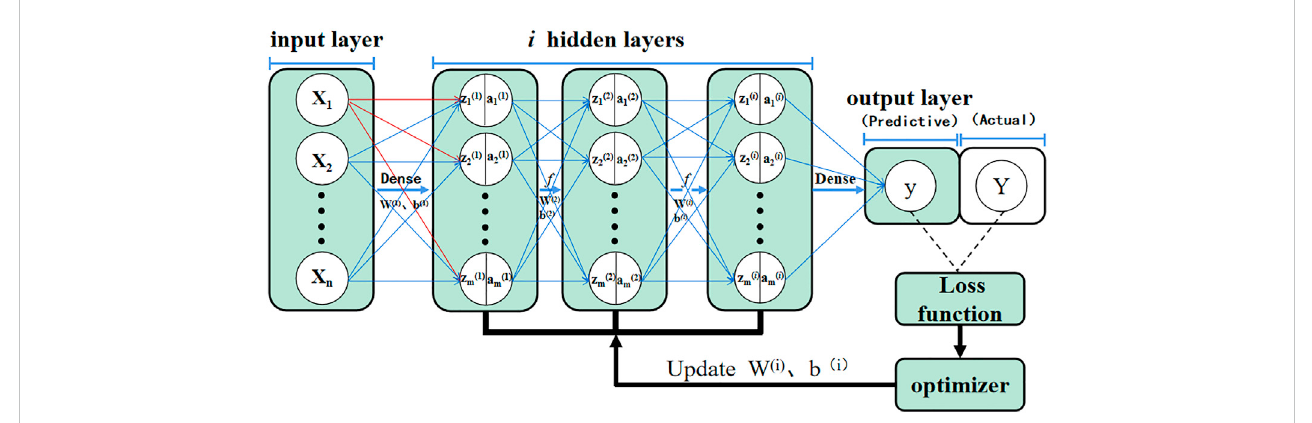
FIGURE 4 Schematic diagram of the